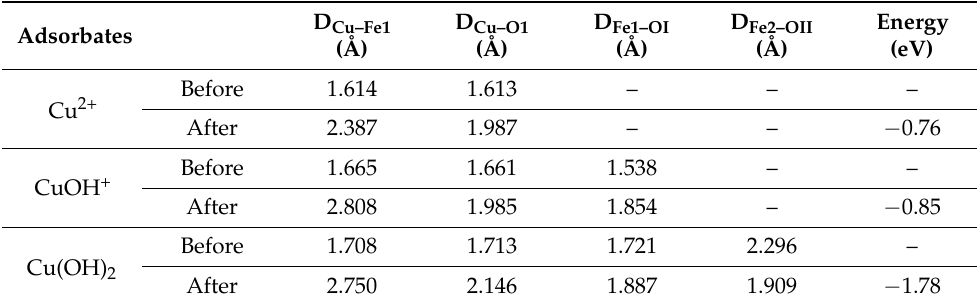
Table 3. Interaction distance and adsorption energy of Cu species before and after adsorption on the surface of specularite. Adsorbates